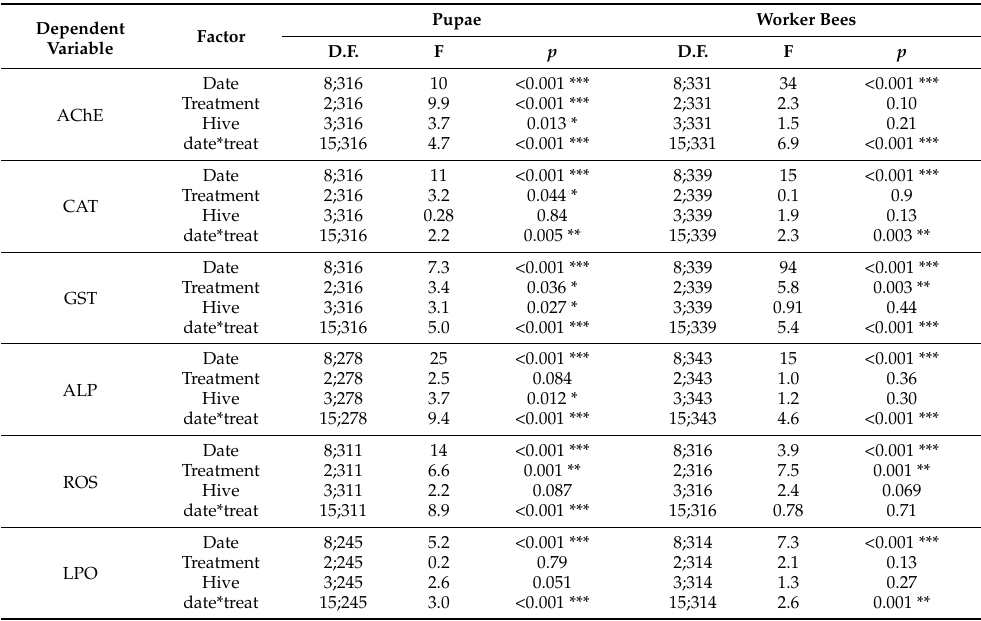
Table 6. GLM of the analyzed biomarkers as dependent variables and “date” “treatment” and “hive” as factors, considering the interaction between date and treatment (date*treat): D.F. = degrees of freedom; F = Fisher’s value; p =